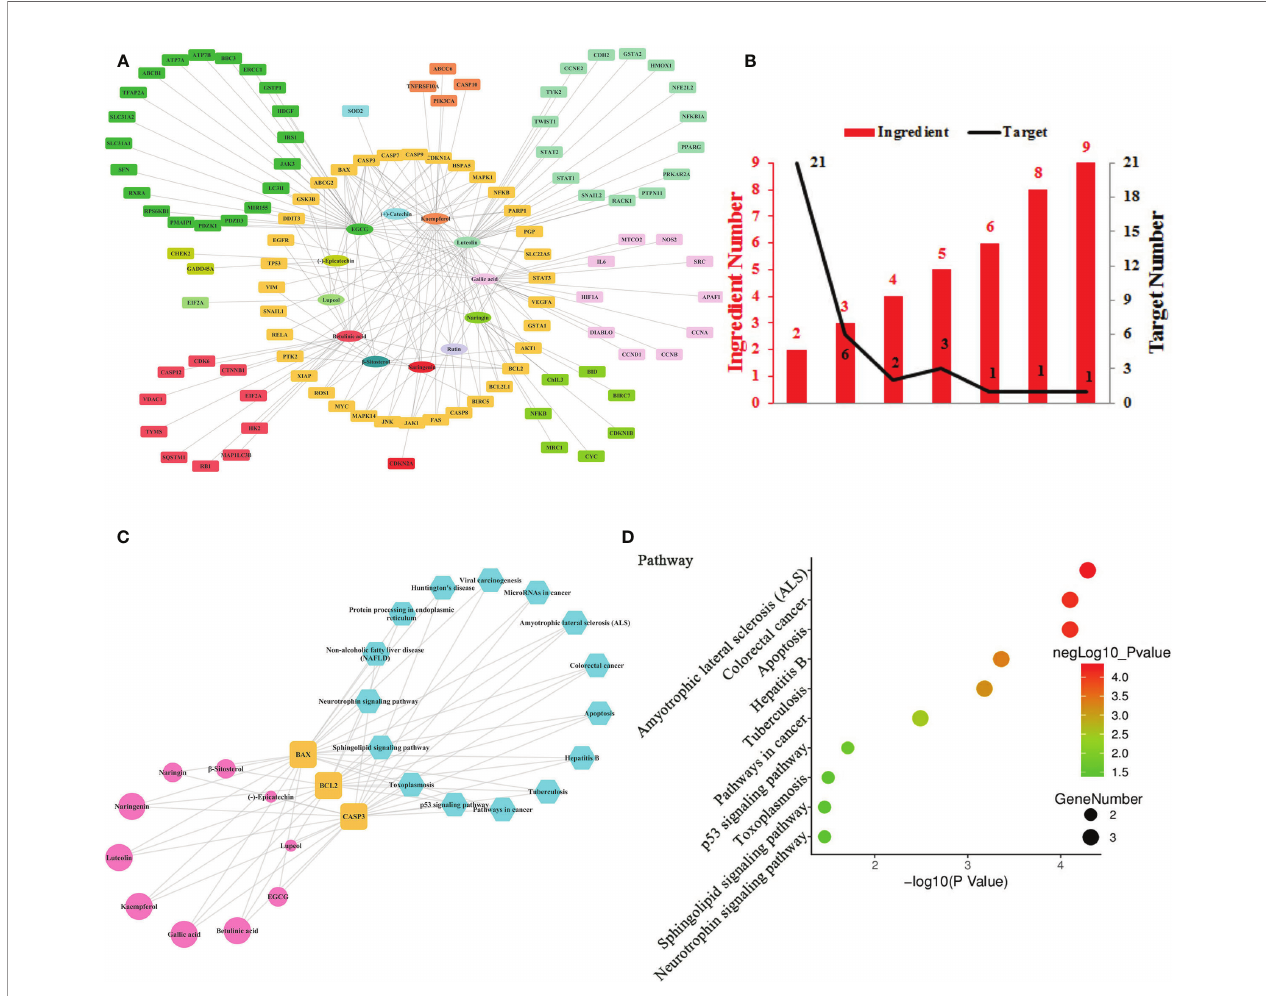
FIGURE 4 | Ingredient-Target Network of Litchi Sensitizing Chemotherapy and Radiotherapy. (A) The ingredient-target network of 12 ingredients (oval) and 106 targets (rectangle). (B) The histogram of “ ingredient and corresponding target number ” . (C) The ingredient-top target-signal pathway network. The round rectangle nodes (orange) are top targets, ellipse nodes (pink) represent ingredients acting on top targets, the node size of ingredients is proportional to the degree values, the hexagon nodes (blue) represent signal pathways enriched based on top targets. (D) The top 10 pathways based on KEGG enrichment